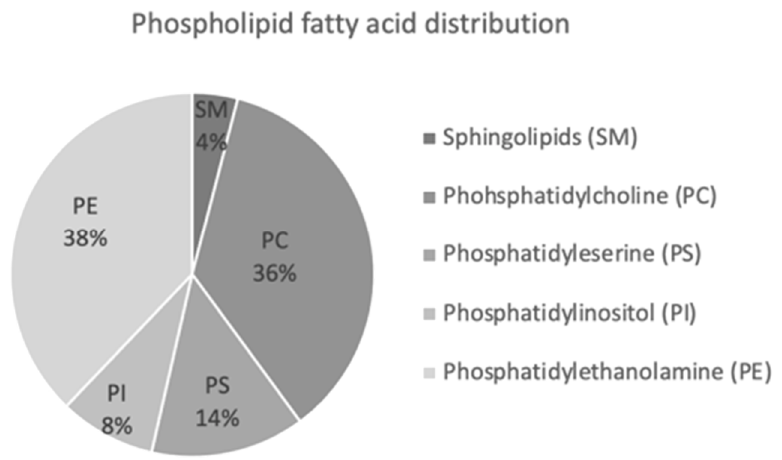
Figure 8. Phospholipid fraction distribution (calculated based on fatty acid composition per each fraction).